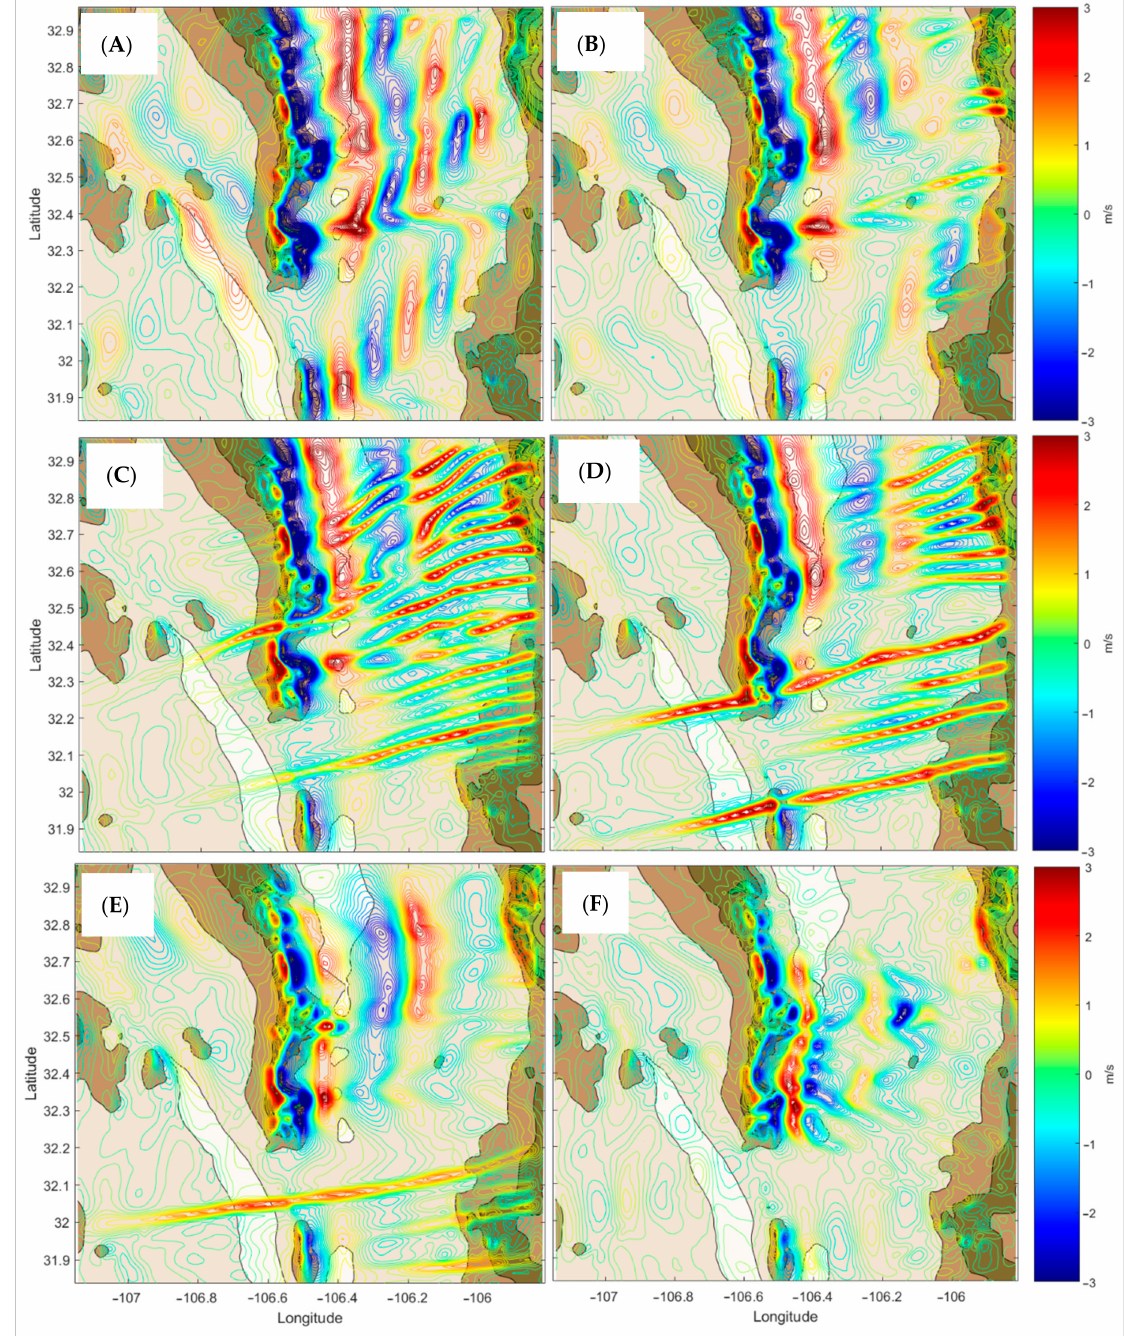
Figure 8. WRF w velocity horizontal cross section at 1000 m agl JER showing the synoptic forced flow regimes, 17 April 2018. ( A ) 1700 UTC, lee wave regime. ( B ) 1900 UTC, LRS transition—LRS forming at base of Sacramento Mountains (eastern side of domain) below the lee waves. ( C ) 2100 UTC, fully developed LRS. ( D ) 2300 UTC, LRS propagating laterally towards the southeast while lee waves are above the LRS indicating the transition to lee waves is occurring. ( E ) 0100 UTC, lee waves above LRS indicating the transition to lee waves. ( F ) 0300 UTC, post LRS lee